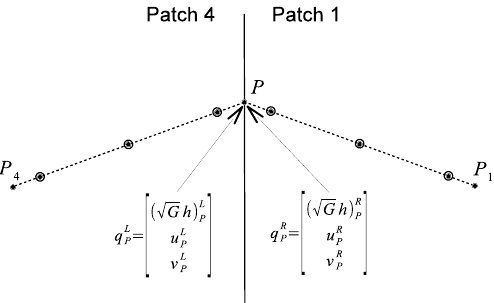
Figure 7. The Riemann problem along patch boundary edge be- tween patch 1 and